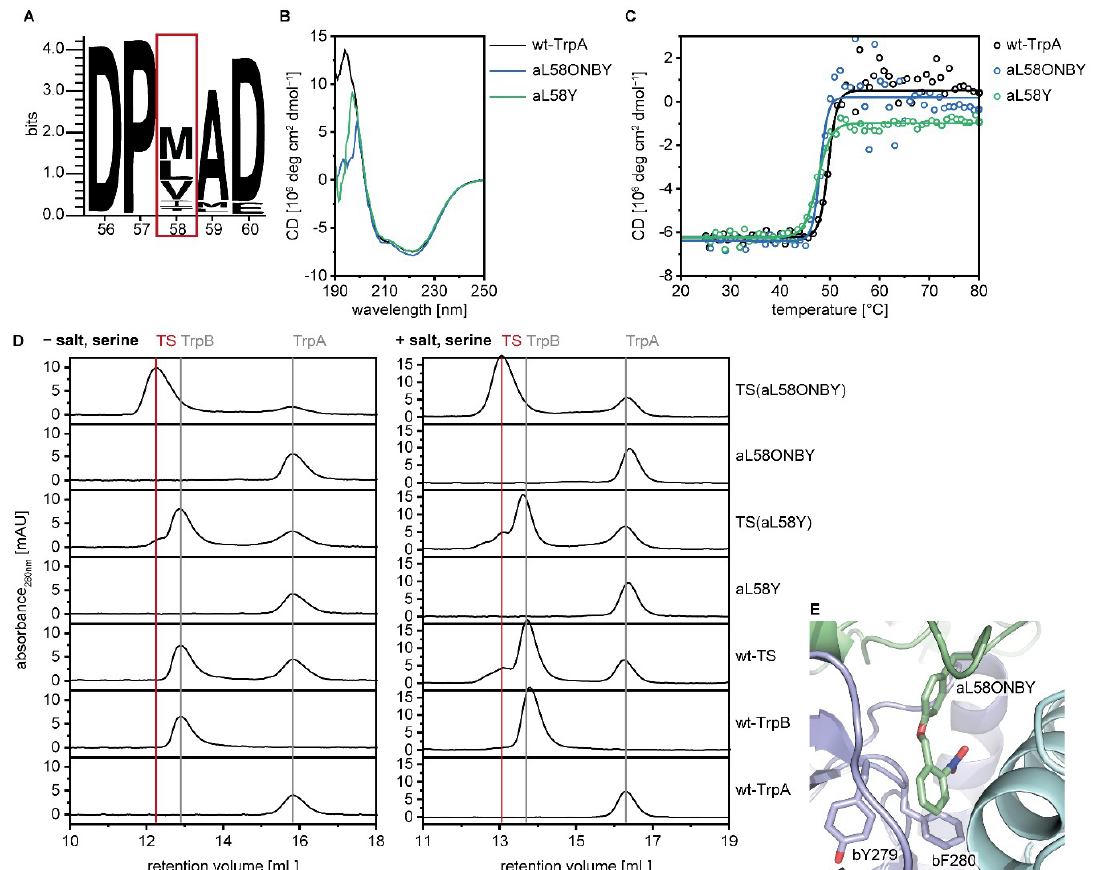
Figure 3. Biochemical characterization of wild-type TrpA, aL58ONBY, and aL58Y. ( A ) Sequence logo of positions 56–60 in TrpA. ( B ) Circular dichroism (CD) spectra of 10–15 µM wild-type TrpA, aL58ONBY, and aL58Y in 50 mM Tris·HCl pH 7.5. ( C ) CD thermal stability measurements recorded at 210 nm of wild-type TrpA ( T m = 50 °C), aL58ONBY ( T m = 48 °C), and aL58Y ( T m = 47 °C). ( D ) Analytical size-exclusion chromatography (Superdex S75 column) of the monomeric subunits and the TS complexes of wild-type TrpA, aL58ONBY, and aL58Y (30 µM) in 50 mM Tris·HCl pH 7.5 or (65 µM) in 50 mM Tris·HCl pH 7.5, 100 mM NaCl, 5 mM serine. ( E ) Positioning of the ONBY residue as determined in a molecular dynamics (MD) simulation after 100 ns of TS(aL58ONBY) (TrpA: Green, TrpB: Blue, COMM domain: Cyan). Representativeness of this snapshot has been verified as described in materials and methods.